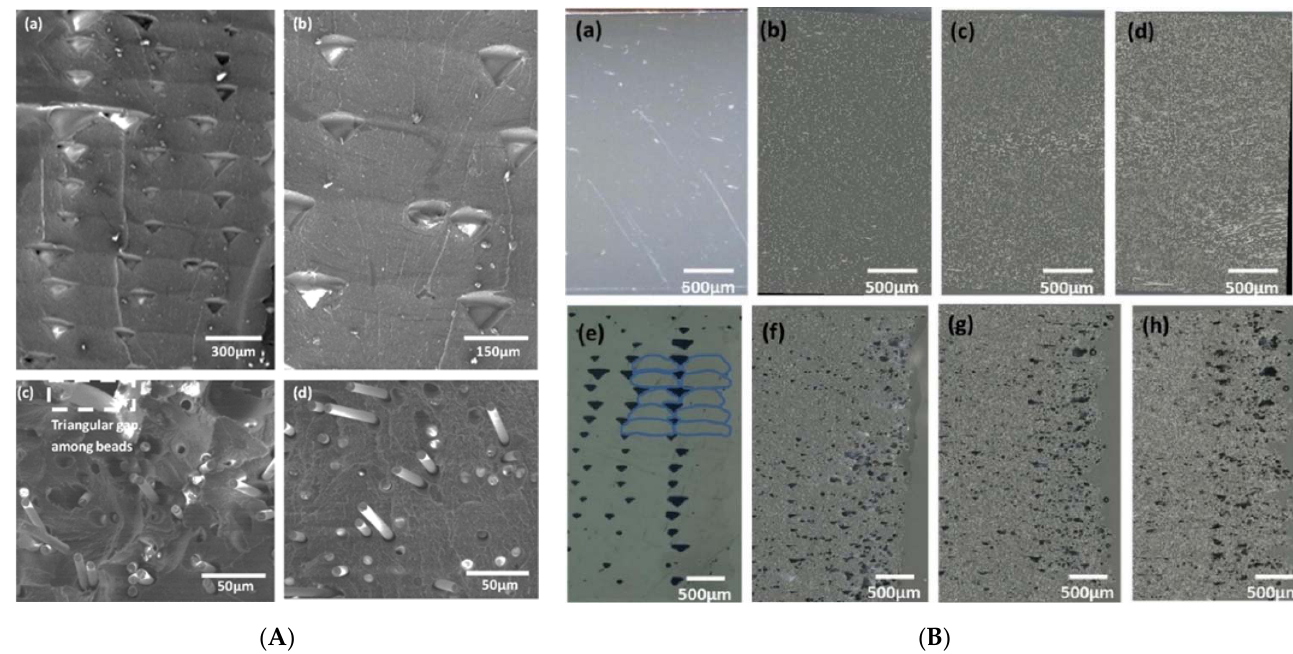
Figure 20. ( A ) Fractography of ( a , b ) conventional FDM-ABS ( c ) FDM printed with 10% wt. carbon fiber and ( d ) 10% wt. carbon fiber compression molded [60]. ( B ) Short fiber-based composites by compression molding ( a – d ), FDM-printed short fiber composites ( e – h ) with the fiber volume fraction changing from unfilled to 30 wt.% with a 10% increment [60] (reprinted with kind permission from Elsevier).